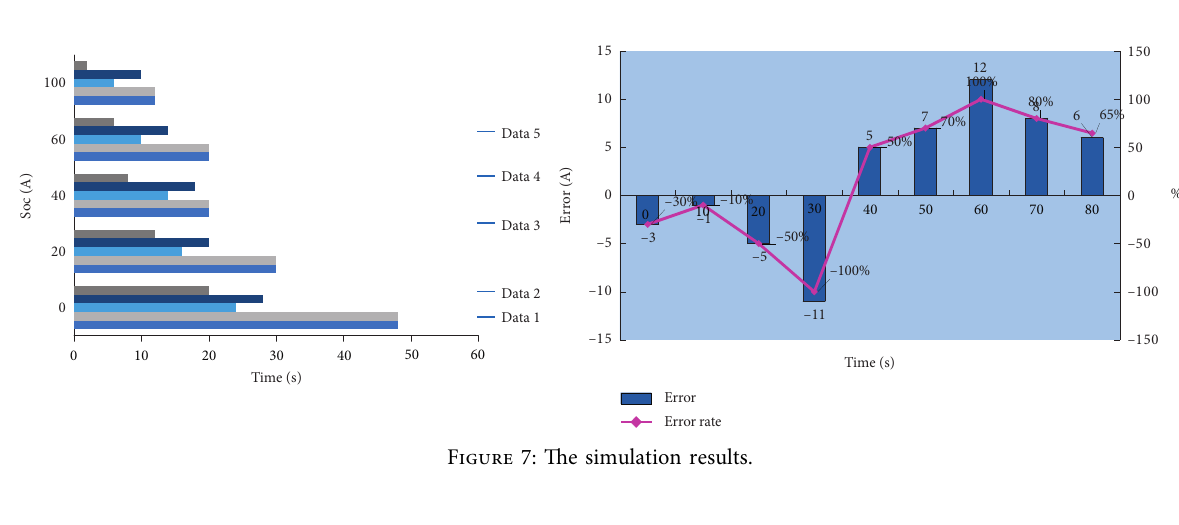
Figure 7: The simulation results.